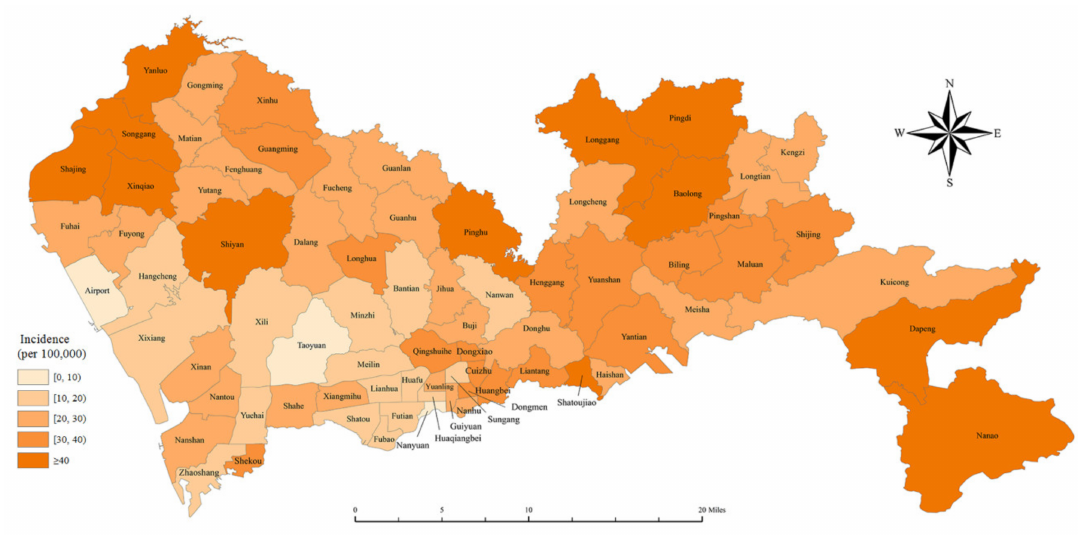
Figure 3. Geographic distribution of crude incidence of lung cancer in Shenzhen, 2008–2018. (Note: geographical level =